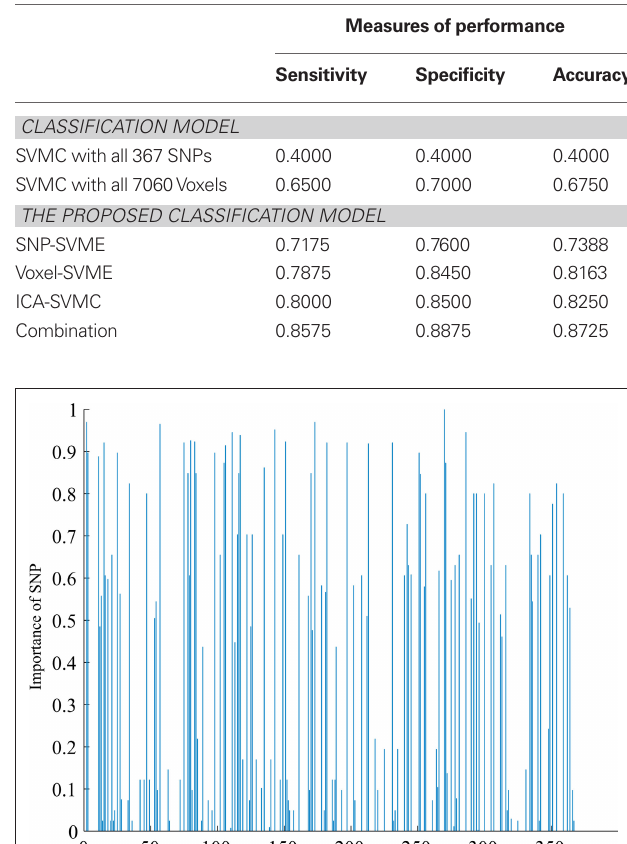
Table 1 | Performance of the classification model.